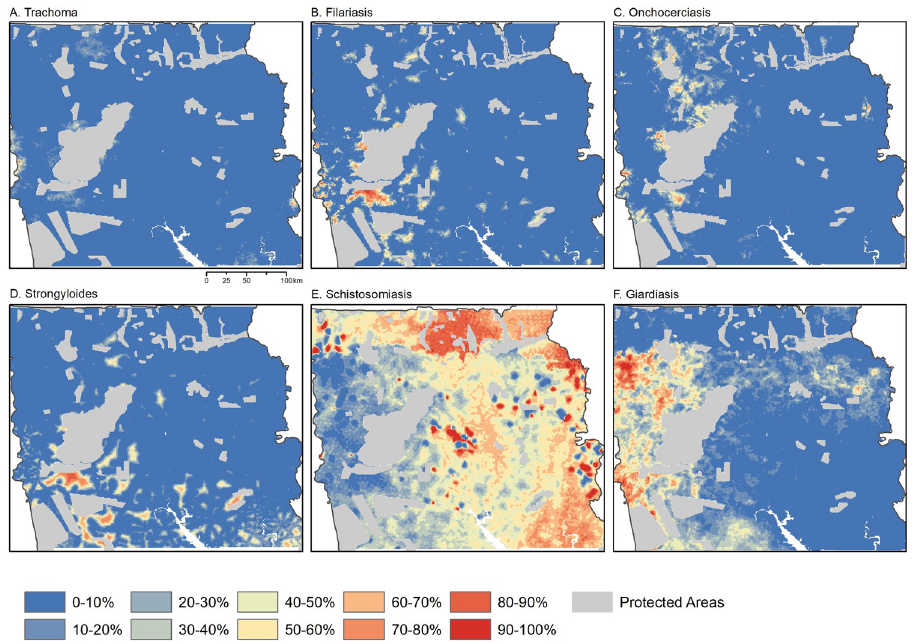
Fig 2. Posterior estimates of the probability of exceeding 10% seroprevalence of high responders to A) Trachoma Pgp3; B) Lymphatic filariasis Wb123; C) Onchoceriasis Ov16; D) Strongyloidiasis NIE; E) Schistosomiasis SEA; F) Giardiasis VSP3; administrative shapefiles obtained from National Information Technology Agency (NITA), Government of Ghana (https://data.gov.gh/dataset/shapefiles-all-districts-ghana-170-districts).